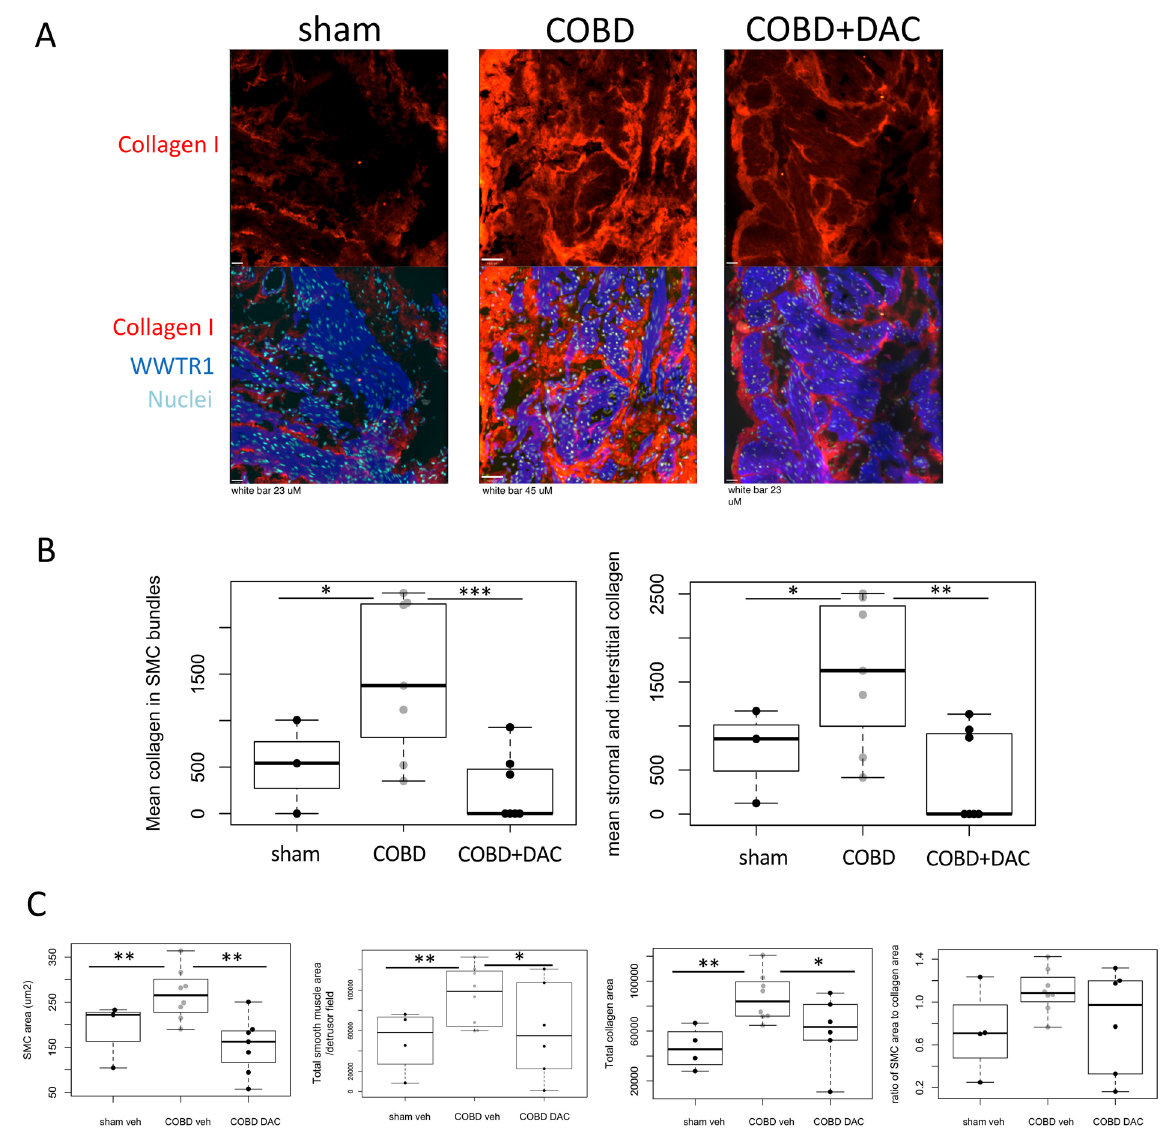
Figure 2. COBD increased collagen type I expression within SMC bundles, while decitabine (DAC) treatment reversed changes in ECM. ( A ) Collagen type I expression by immunofluorescent staining (RED) was increased and more widely distributed during COBD. ( B ) Analysis on Volocity 6.3 revealed that DAC treatment decreased collagen expression significantly in bladder SMC compartments (identified by WWTR1 staining in far-red-blue). ( C ) The SMC area (size of smooth muscle cells) and area occupied by the SMC in the detrusor fields was quantified on Volocity, by counting nuclei and the areas of the detrusor. The SMC area and the total smooth muscle/field was increased by chronic obstruction and reduced by decitabine treatment. Total collagen area was also significantly altered by COBD and DAC treatment. A ratio of the total SMC area to collagen areas in each field were calculated as well (right-most panel), but the ratio was not significantly altered. Nuclei are identified with DAPI (light blue). *p < 0.05 by 1-tailed t-test, **p < 0.05 by 2-tailed t-test, ***p < 0.01 by 2-tailed DAC treatment of COBD results in reduction of specific BDNF isoforms. Previously, a high throughput quantitative PCR (HT-qPCR) array showed that BDNF and CTGF increase with 6 week obstruction and correlate with function 26 . In addition, acute obstruction plus DAC treatment, further increases BDNF 26 . Here we found that during COBD, CTGF expression remained higher than sham with or without DAC treat- ment (Fig. 3, p < 0.05, 2-tailed t-test, sham 0.87 ± 0.08 vs. COBD 1.78 ± 0.27 and COBD + DAC 1.52 ± 0.13). Also, BDNF variants 1 and 5 were both significantly increased (Fig. 3, p < 0.05) during COBD (sham BDNF var1 1.03 ± 0.55 and var5 1.34 ± 0.82, vs. COBD BDNF var1 15.32 ± 8.70, BDNF var5 147 ± 72, respectively). For comparison of sham vs. COBD, negative ddc(t) values were utilized for 1 and 2 tailed t-tests for variants 5 and 1, respectively. COBD levels were reduced by DAC to sham levels (COBD DAC BDNF, var1 1.38 ± 0.39 and var5, 0.81 ± 0.19, p < 0.05, 2-tailed t-test). From our previous work, we also examined genes affected by